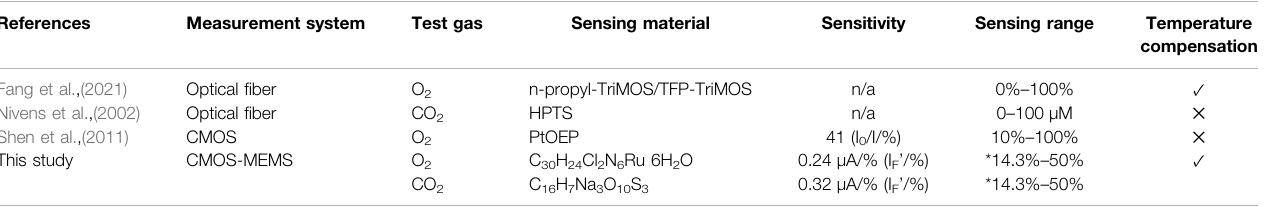
TABLE 1 | Comparison of presented CMOS-MEMS optical gas sensors with existing optical-based gas